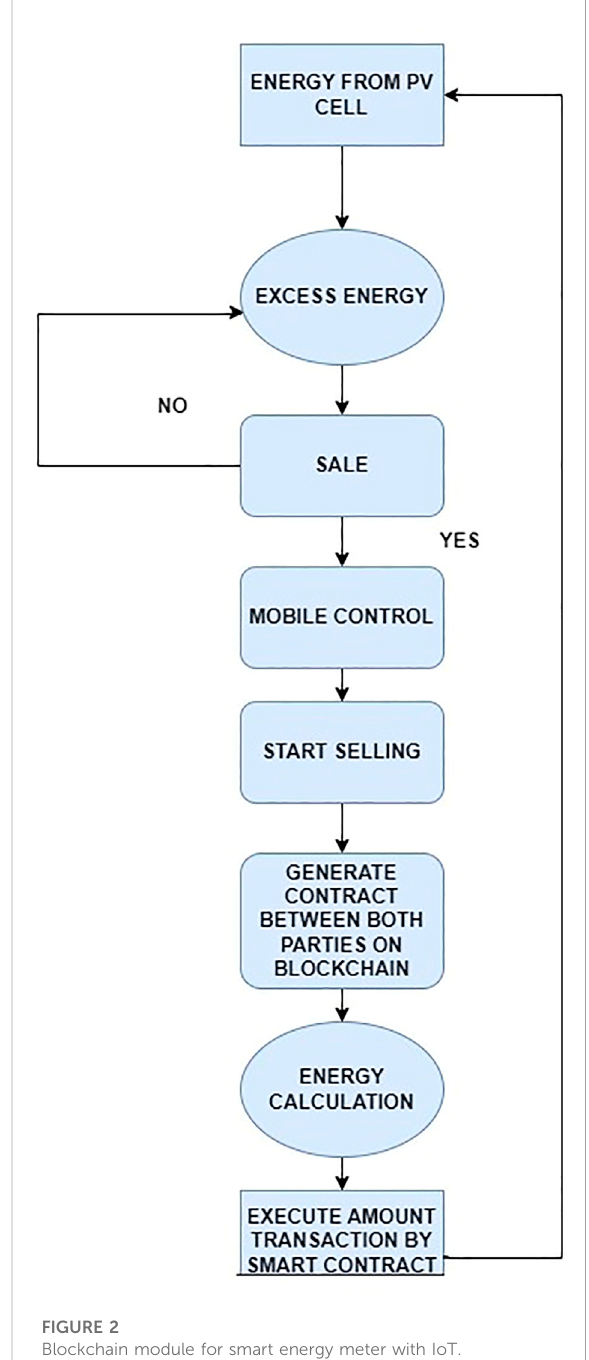
FIGURE 2 Blockchain module for smart energy meter with